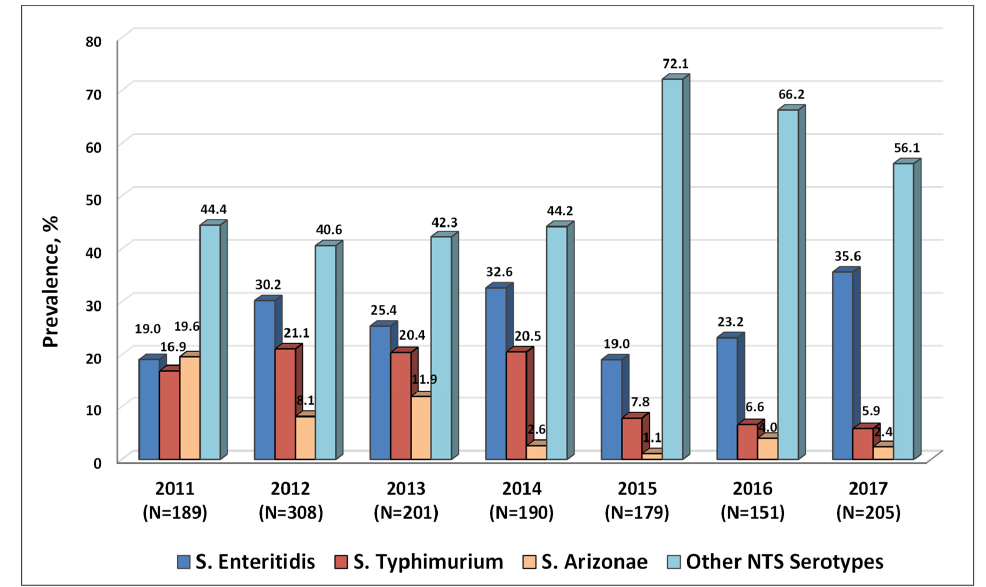
Figure 2. Serotypes of 1423 human non-typhoidal Salmonella (NTS) isolates recovered from patients admitted to the Nork Infectious Clinical Hospital (Ministry of Health, Armenia) in 2011–2017.